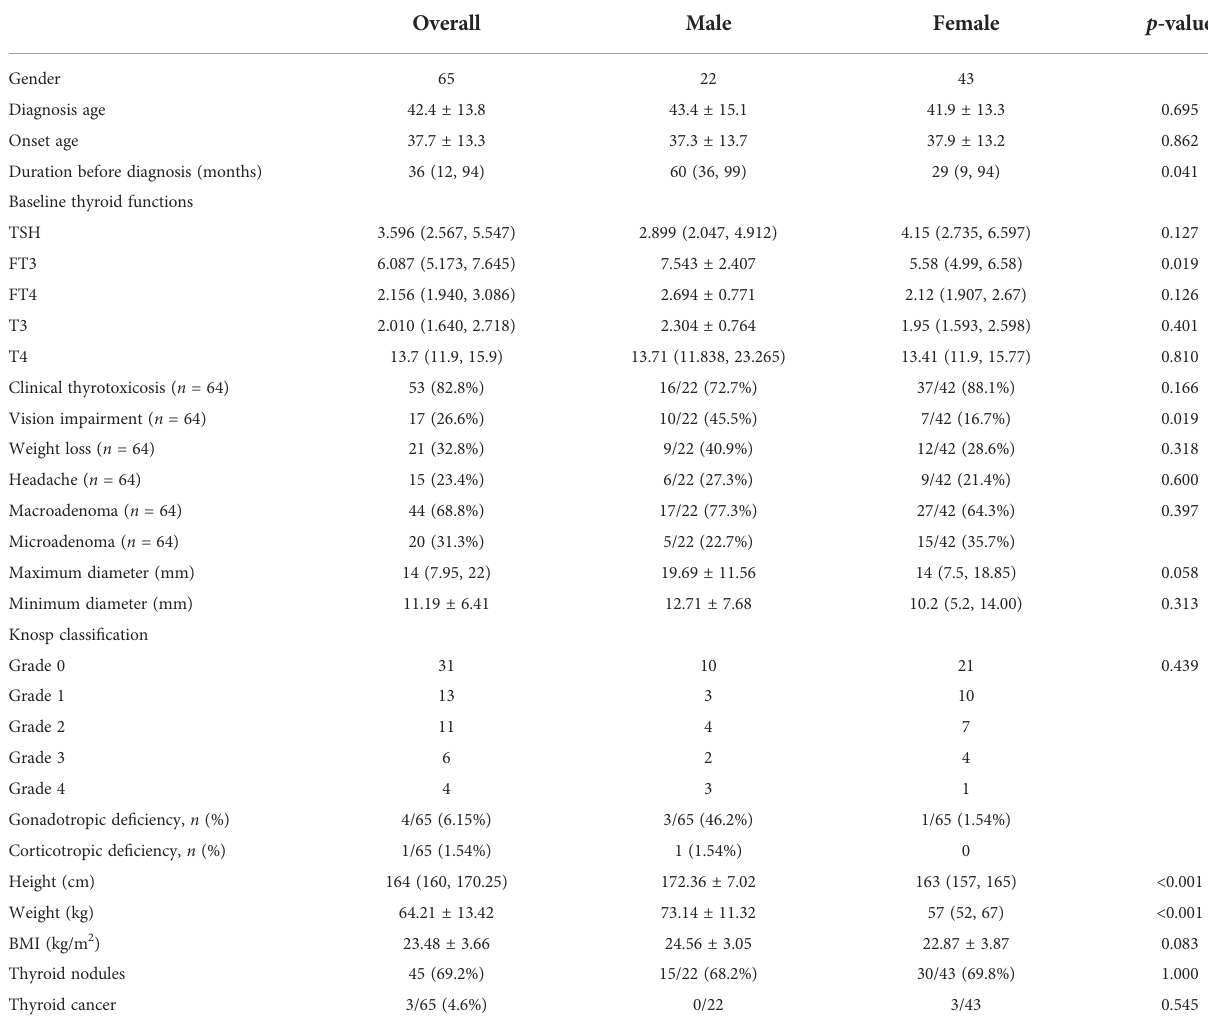
TABLE 1 Baseline characteristics of the